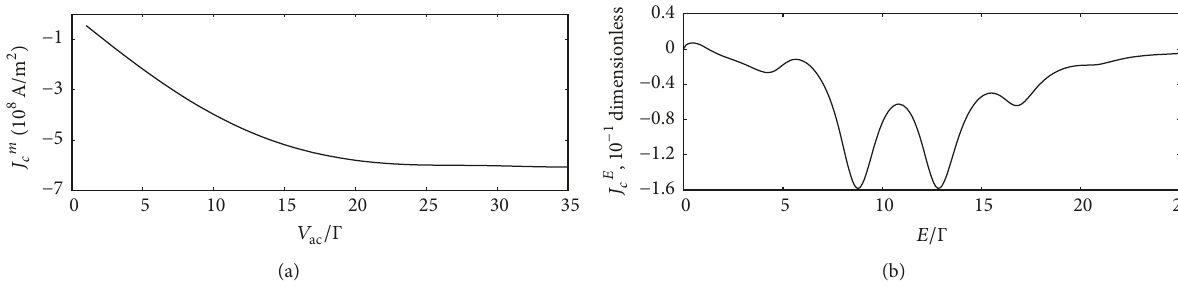
Figure 9: (a) Maximum absolute value of the negative active current current 𝐽 𝑐𝑚 as a function of amplitude of the AC electric field for RTD heterostructure number 1 at the frequency ℏ𝜔 = 4Γ . (b) Dimensionless electron contribution to the active current as a function of the energy of the electron for amplitude of the AC electric field 𝑉 ac = 25Γ , frequency ℏ𝜔 = 4Γ , and RTD heterostructure number 1.